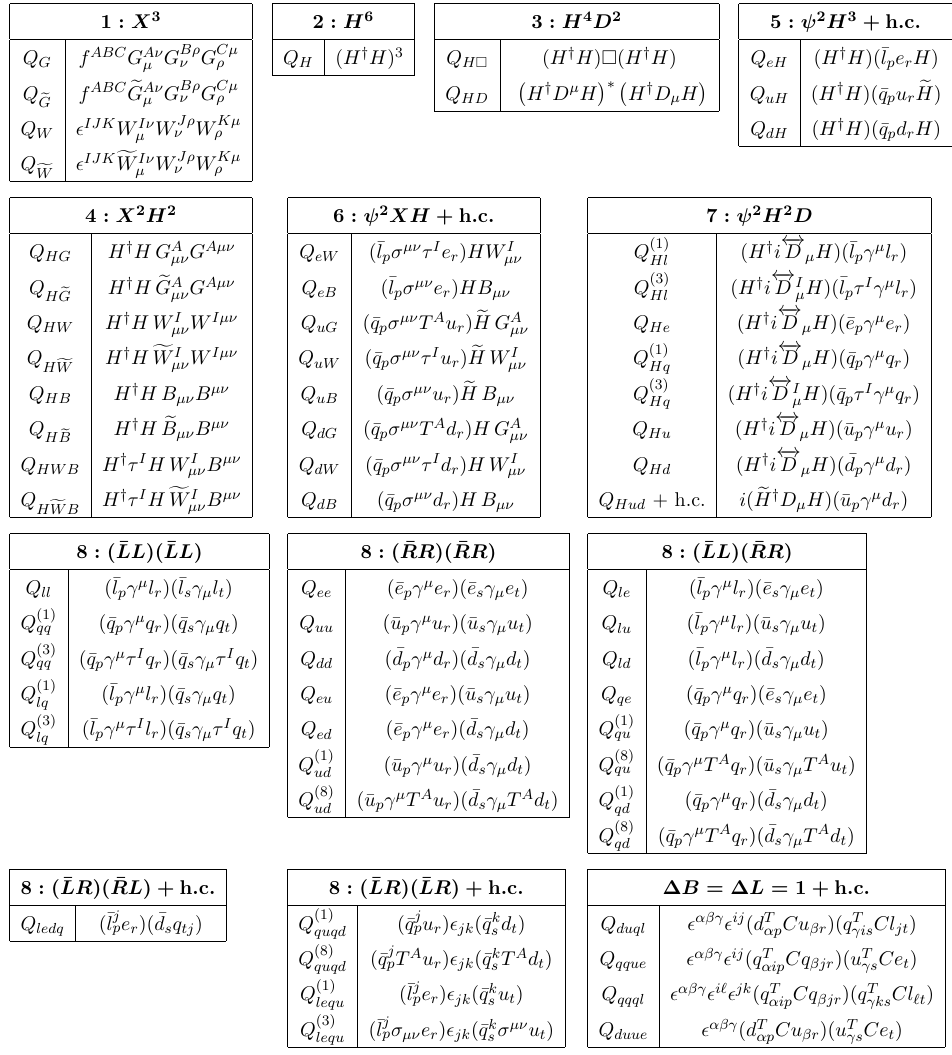
Table 2 . The dimension-six operators in SMEFT. The operators that conserve baryon and lepton number are divided into eight classes according to their (cid:12)eld content. The class-8 4 four-fermion operators are further divided into subclasses according to their chiral properties. Operators with + h : c : have Hermitian conjugates. The subscripts p; r; s; t are weak-eigenstate indices.